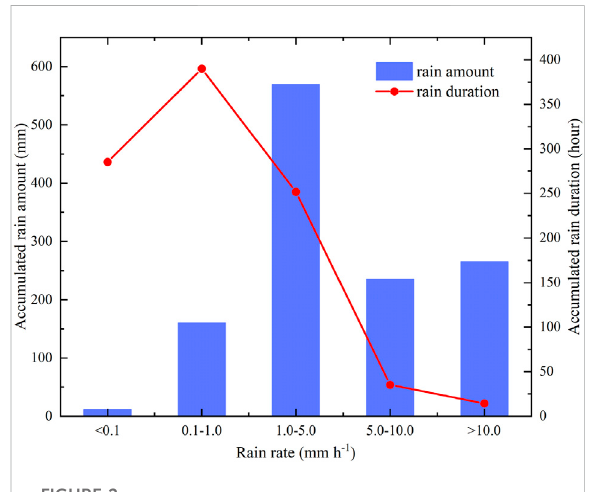
FIGURE 2 Accumulated duration (red) and rain amount (blue) for fi ve rain-rate regimes.